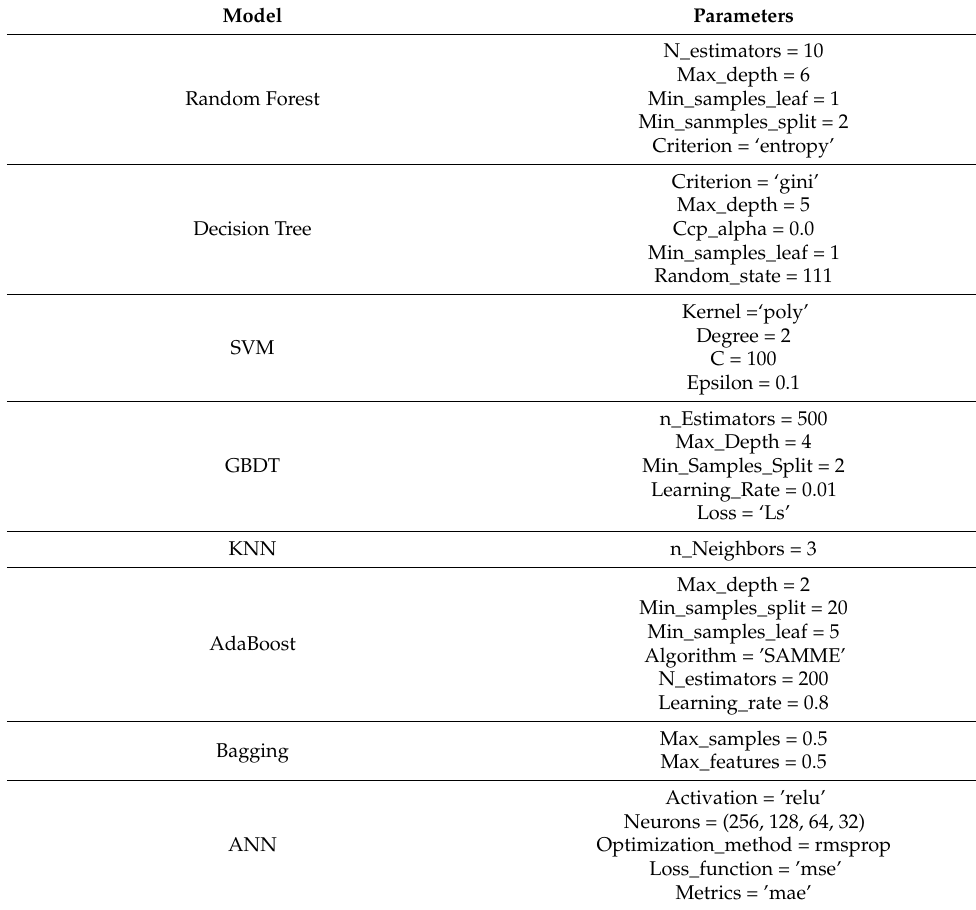
Table 2. Optimal parameter of the eight machine learning